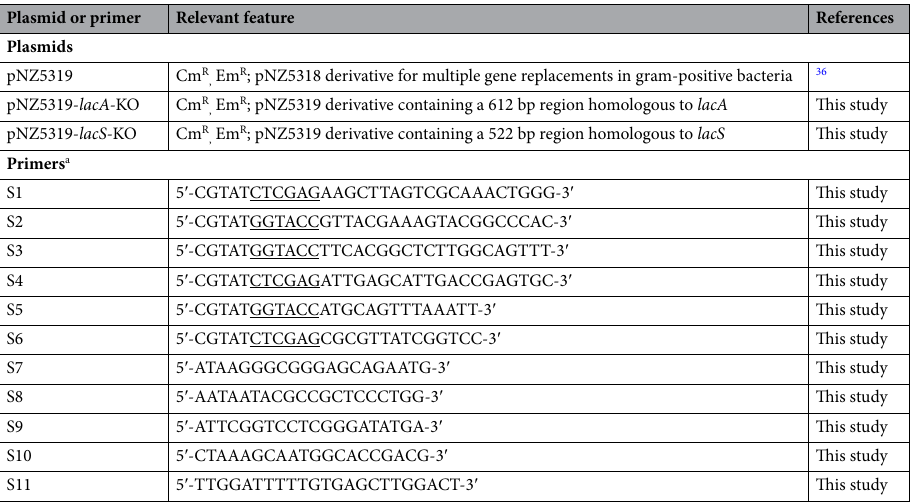
Table 2. Plasmids and primers used in this study. Cm R chloramphenicol resistant, Em R erythromycin resistant. a Underlined sequences indicate enzymatic restriction sites.